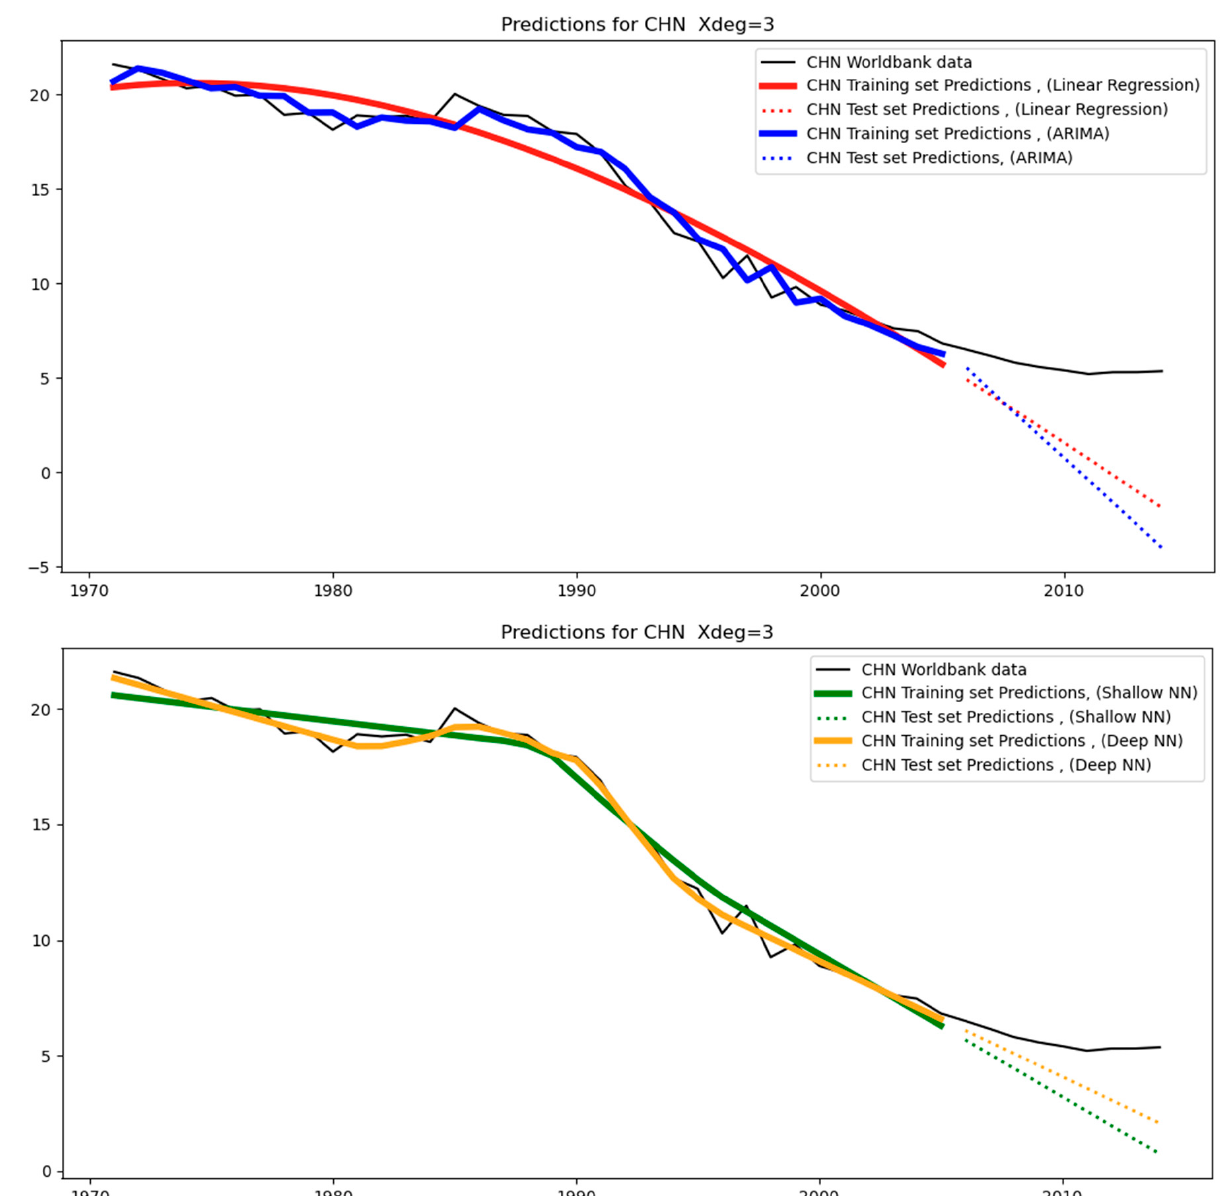
Figure 6. Predictions for China (CHN), with a third-degree polynomial (Xdeg = 3), are shown for both the training set (periods 1971–2005) and the test set (periods 2006–2014), using linear regression (LR), ARIMA, shallow neural networks, and deep neural network models.